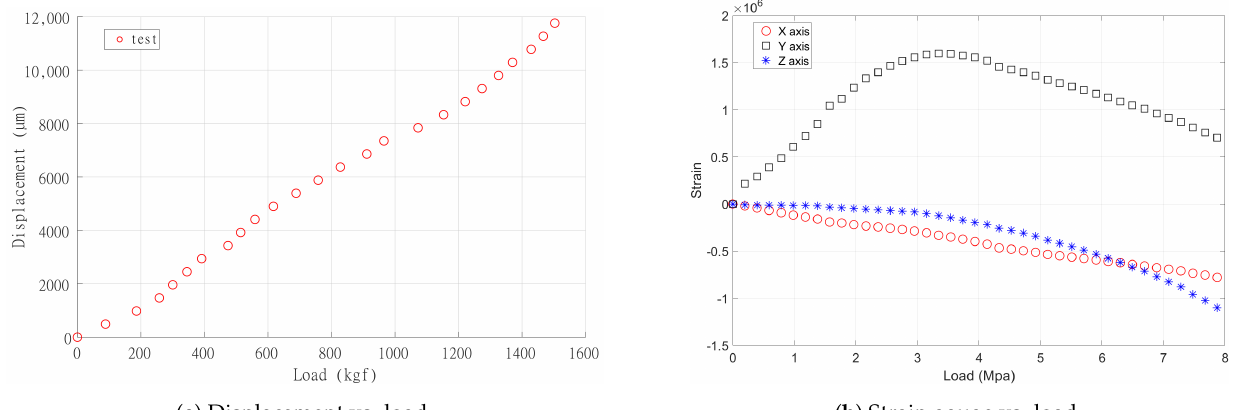
Figure 3. Sensor unit load